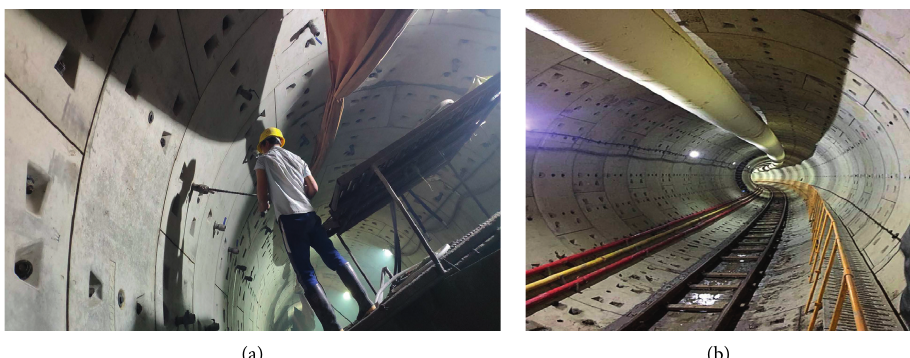
Figure 12: : Photographs of site construction and effect. (a) Scene of secondary grouting. (b) The condition of the pipe after grouting.